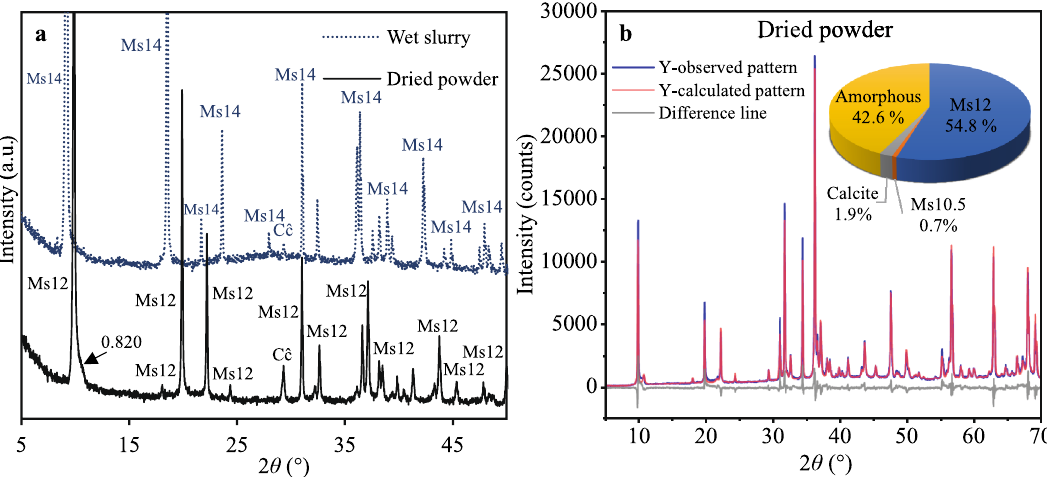
Figure 3. XRD patterns ( a ) and QPA results ( b ) of the samples after hydrothermal synthesis. The X-rays with a wavelength of 1.5406 Å (CuKα radiation) were used. Indexes: Ms –monosulfoaluminate (the number shows water content); Cĉ – CaCO 3 .